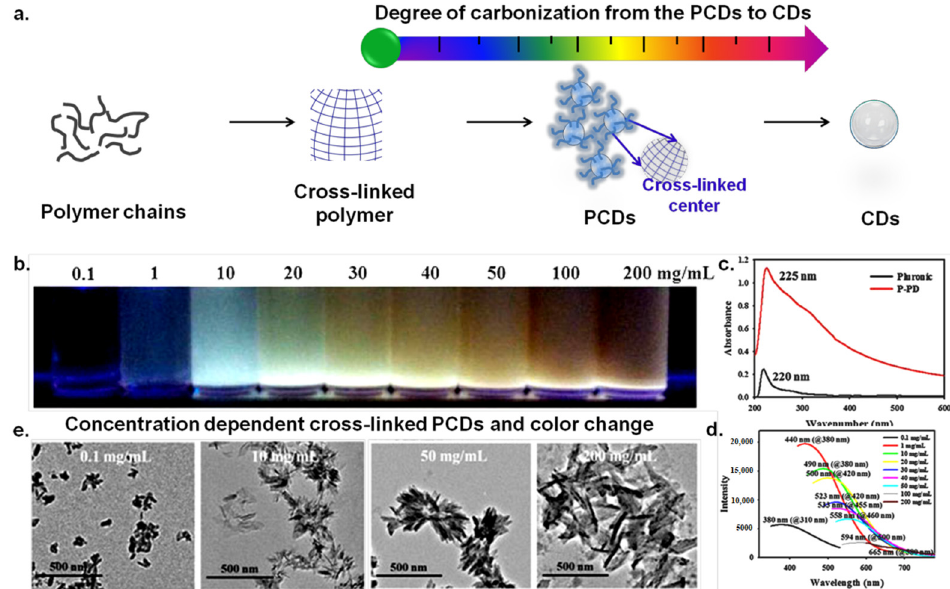
Figure 1. ( a ) The schematic diagram illustrates the cross-linking and degree of carbonization of the carbon polymer dots (CPDs) and carbon dots (CDs). ( b ) The photoluminescence (PL) behaviors of polymer carbon dots (PCDs)-based on cross-linking and concentration. ( c ) The absorption spectrum of precursor PCDs and after synthesis of PCDs (P-PD). ( d ) The concentration dependent fluorescence emission spectrum of PCDs. ( e ) The TEM images of CPDs indicates the polymeric properties and cross-linked nature. Reprinted with permission from ref. [5] Copyright© 2015 John Wiley & Sons, Ltd.